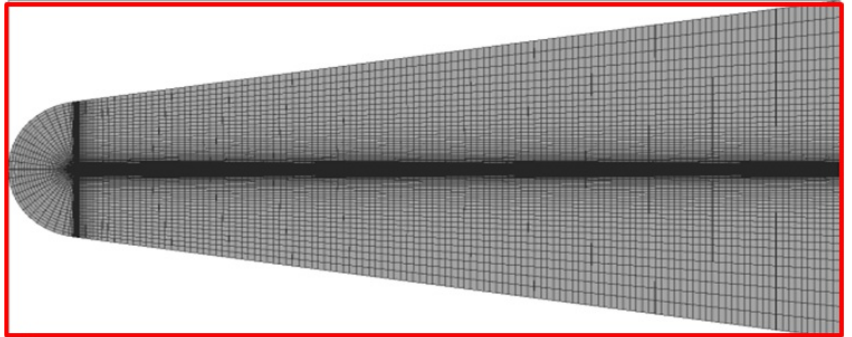
Figure 2. A sizing boxes.